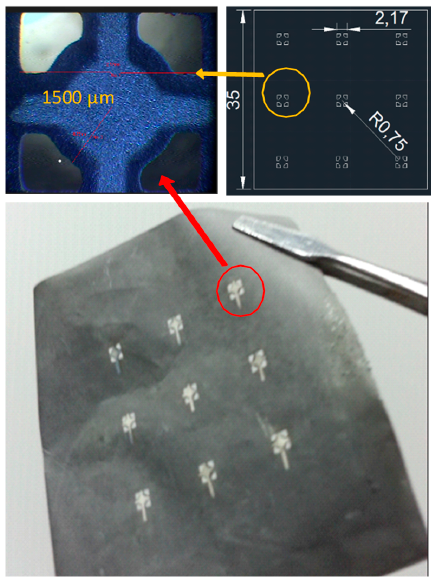
Figure 3. Results of the fabricated PMUT film element array on the patterned titanium foil.